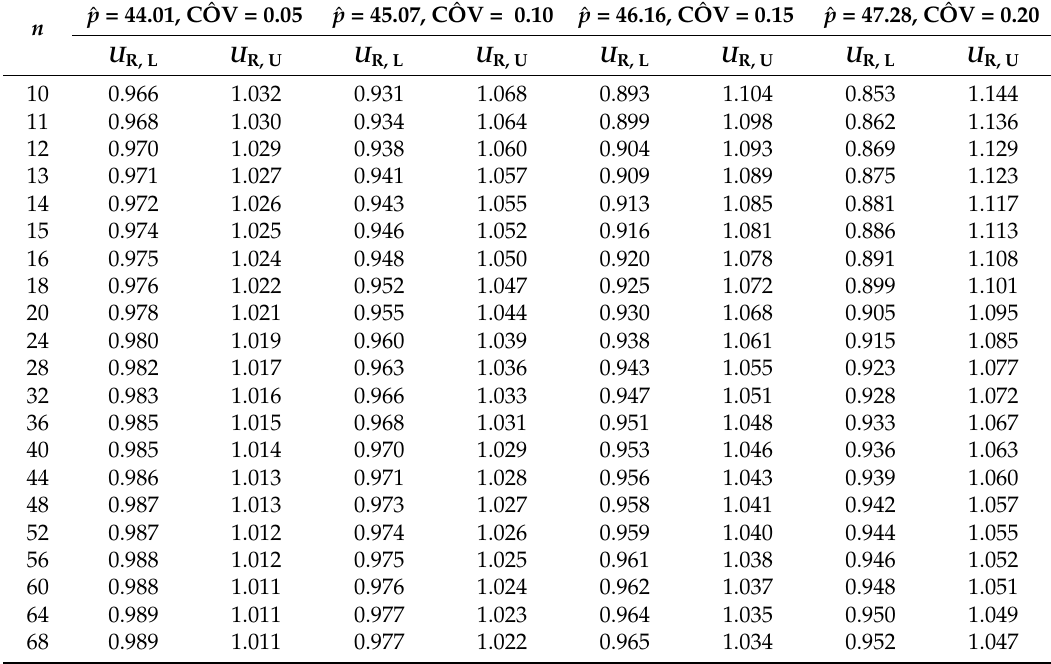
Table 3. x p,L / ˆ x p and x p,U / ˆ x p